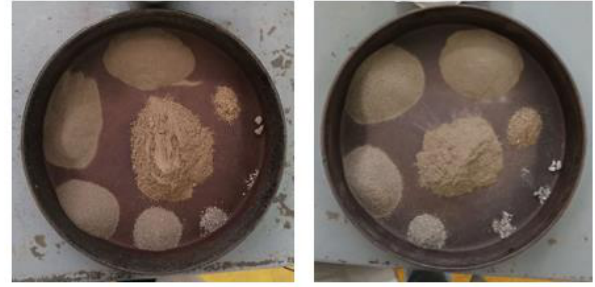
Figure 8. Breakdown and grain size of the adobe samples. Photo: David Preciado Villicaña (2019).